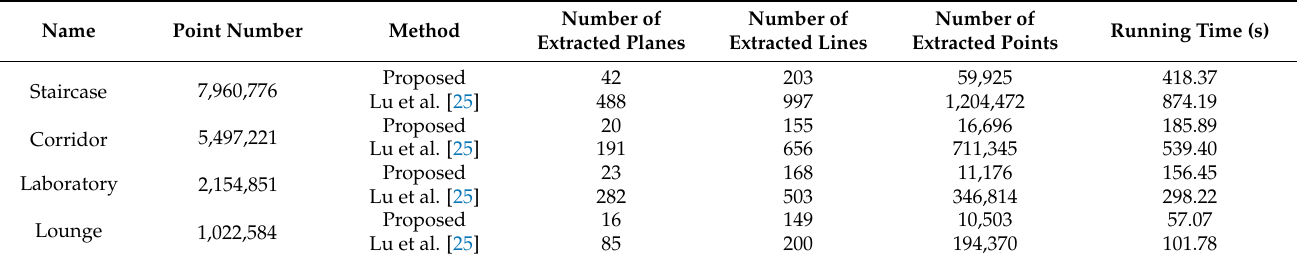
Table 1. Calculation results for four indoor scenes.